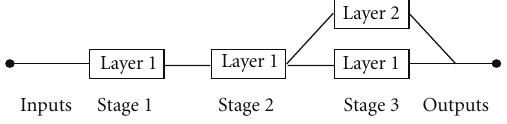
Figure 2: A lateral view of an 8 × 8 multilayer